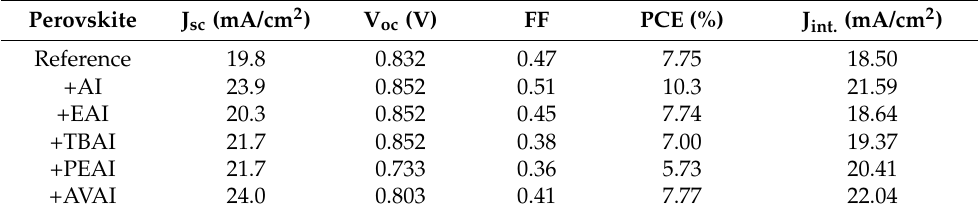
Table 1. Electrical parameters derived from the J-V curves of the champion C-PSCs, incorporating the reference (w/o additive) perovskite and the 5 additive-based perovskites under study. Perovskite J sc (mA/cm 2 ) V oc (V) FF PCE (%) J int. (mA/cm 2 )